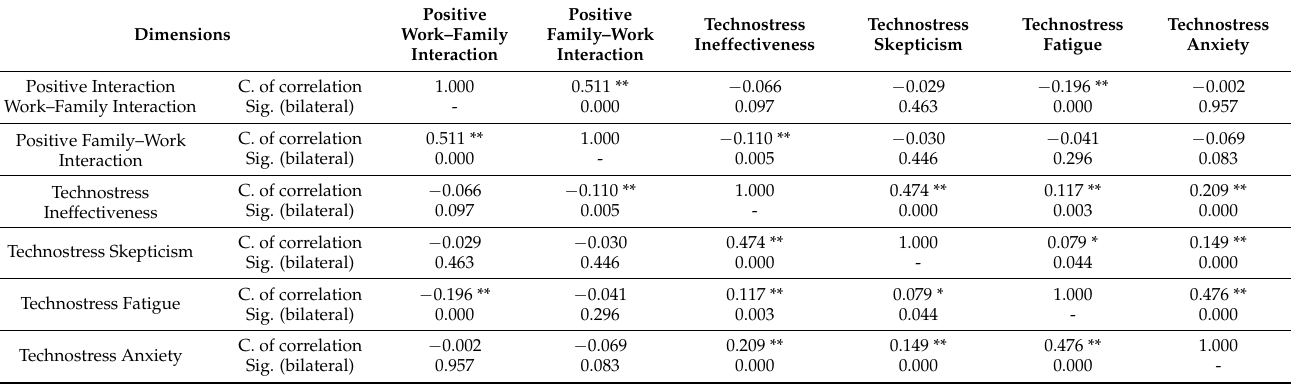
Table 2. Spearman’s rho